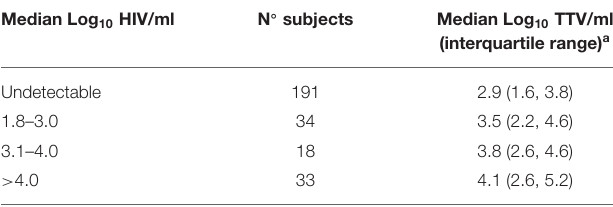
TABLE 3 | Association between TTV in saliva and HIV in the circulation. Median Log 10